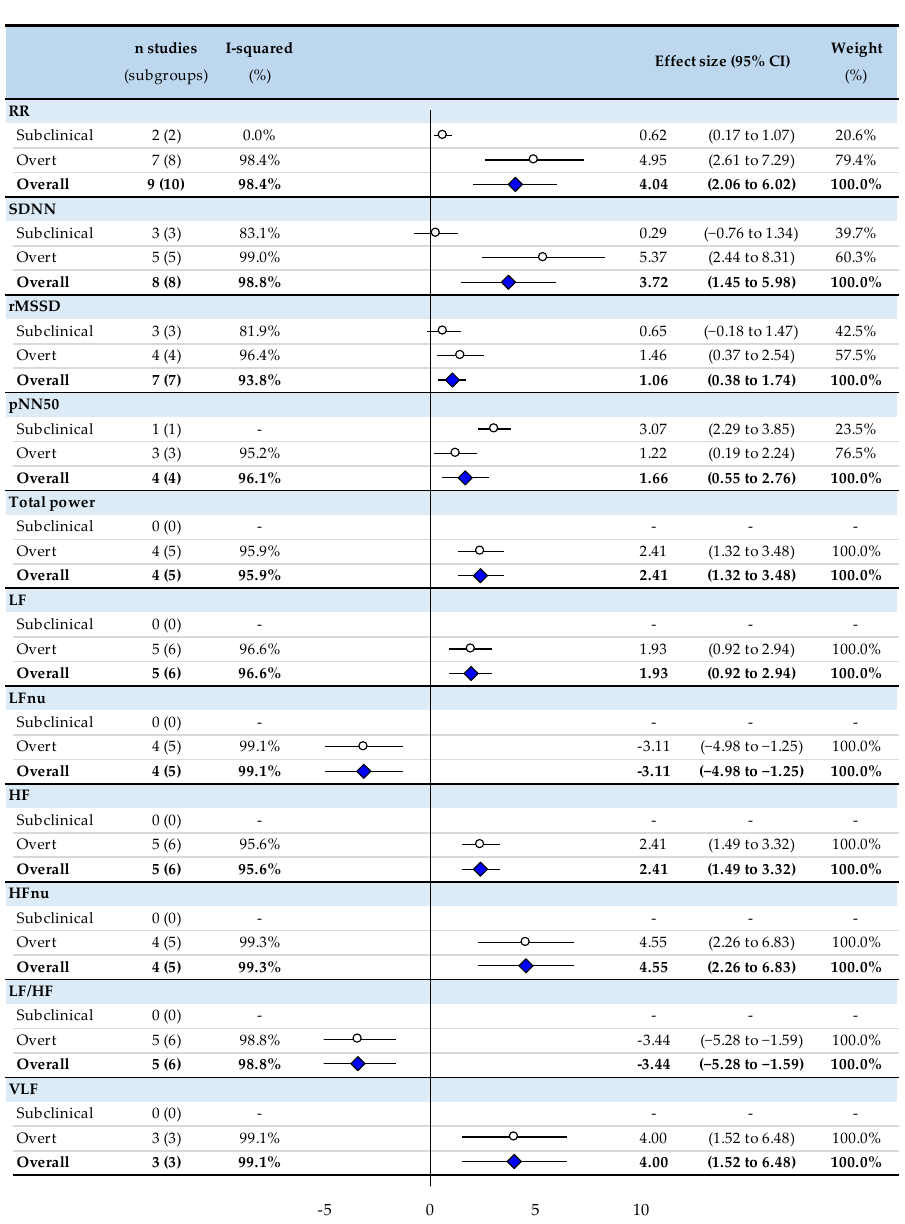
Figure 2. Meta-analysis of HRV parameters of untreated hyperthyroid patients compared with treated hyperthyroid patients. RR: RR intervals (or normal-to-normal intervals-NNs), SDNN: stand- ard deviation of RR intervals, pNN50: percentage of adjacent NN intervals differing by more than 50 milliseconds, RMSSD: the square root of the mean squared difference of successive RR-intervals, LF: low frequency, LFnu: low frequency normalized—units, HF: high frequency, HFnu: high fre- quency—normalized units, LF/HF ratio: low frequency/high frequency ratio, VLF: very low fre- quency. ○ : effect size stratified by subclinical or overt status; : effect size for all studies. ♦